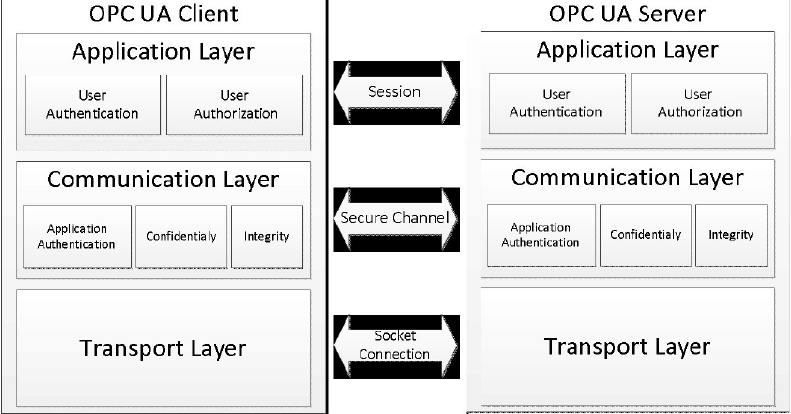
Figure 3. OPC UA security architecture (UA Part2)